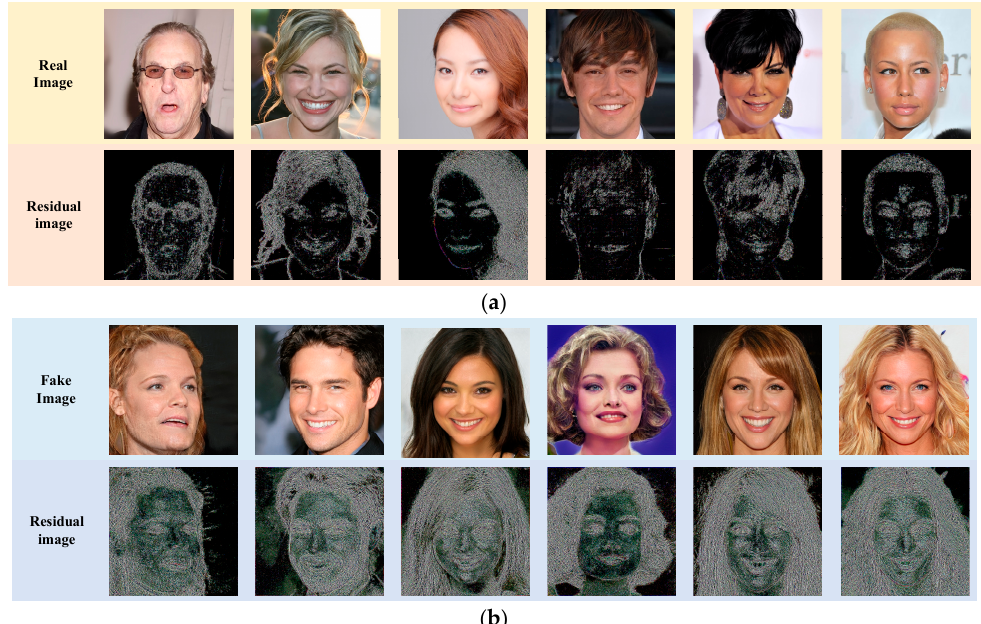
Figure 6. Example of the residual images extracted from the global detection branch. ( a ) The real image groups. ( b ) The fake image groups.